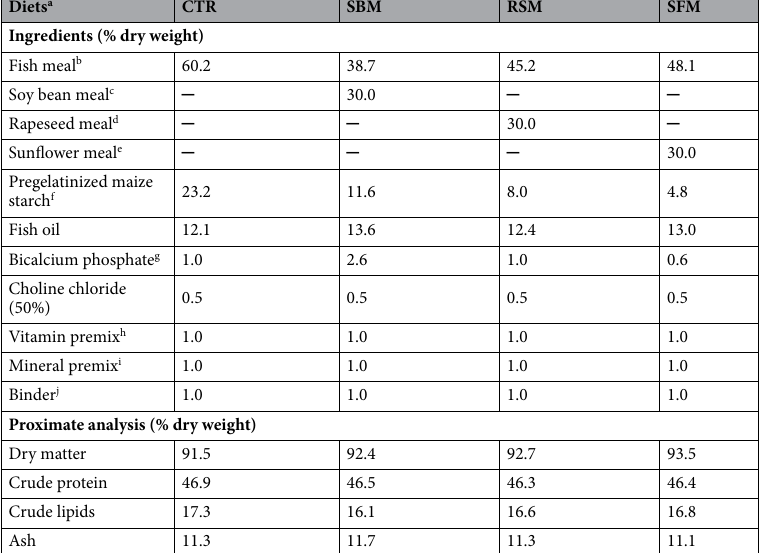
(Table S5); and the Flavobaceriaceae ( p = 0.036) (Phylum Bacteroidetes). Regardless of the diets provided, a core microbiota could be identified in both digesta and mucosa samples (Fig. 4; Table S7). While in Mucosa samples the great majority of genera (206) were present in all diets, in Digesta samples different genera could be assigned to samples of different experimental diets, confirming the higher stability of mucosal microbiota versus digesta microbiota.